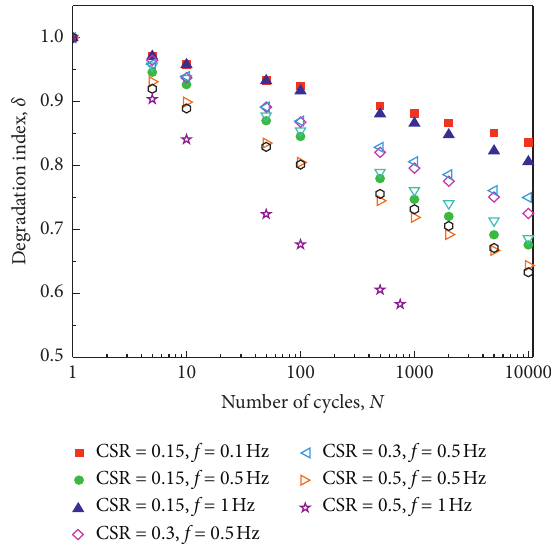
Figure 8: Development of the degradation index under different f values: f � 0.1Hz, f � 0.5Hz, and f �